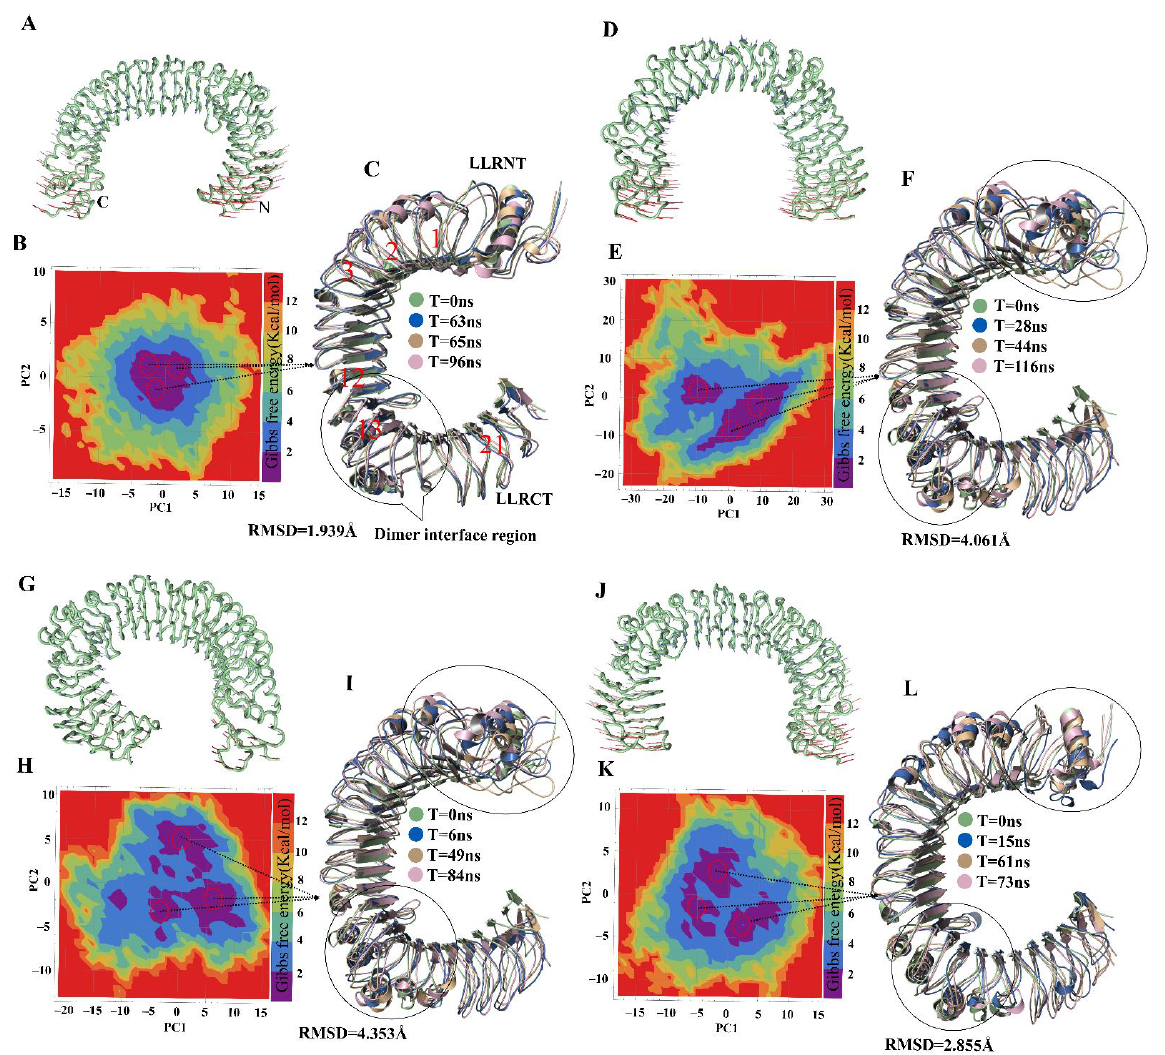
Figure 2. Motion and FEL of TLR4 wt and its muteins. The motion of N and C termini in a porcupine plot of ( A ) TLR4 wt is outward and in ( D ) it is inward with large magnitude, and for ( G ) TLR4 Y329A and ( J ) TLR4 K349A , it is irregular. The FEL was computed using PC1 and PC2 as reaction coordinates for ( B ) TLR4 wt , where all conformations remained confined to one minimum. ( E ) TLR4 Y328A conformations split into two minima with higher energy barrier. ( H ) TLR4 Y329A and ( K ) TLR4 K349A split into three minima. A representative lowest-energy structure from local minima indicated by red circles was superimposed ( C , F , I , L ) with the respective first or 0 ns frame structure in TLR4 wt and mutants shown along with the RMSD values. The black circle exemplifies the variation in structure at the epitopic region or dimer interface and termini.